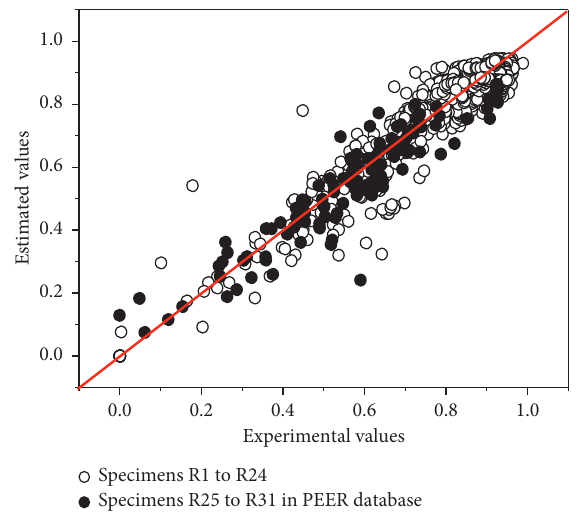
Figure 15: Estimated values and experimental values of D each half-cycle for 31